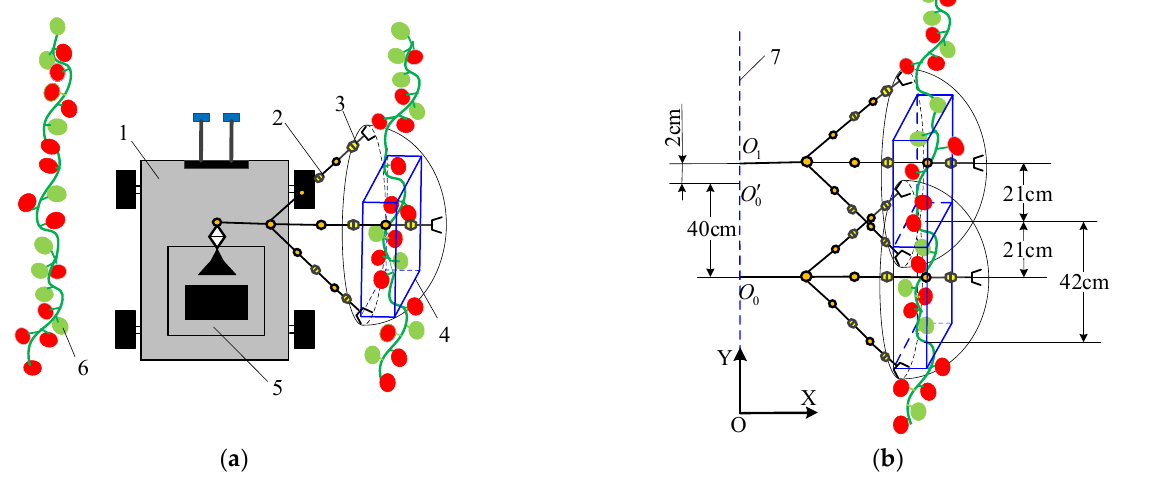
Figure 5. Schematic diagram of the working space of the picking robotic arm. ( a ) Individual picking areas; ( b ) Two adjacent picking areas. 1: wheeled chassis; 2: mechanical arm; 3: end-effector; 4: fan- shaped picking operation space area; 5: lift platform; 6: fruit; 7: walking ridge road; O 0 , O (cid:48) 0 : ideal stop point; O 1 : actual stop